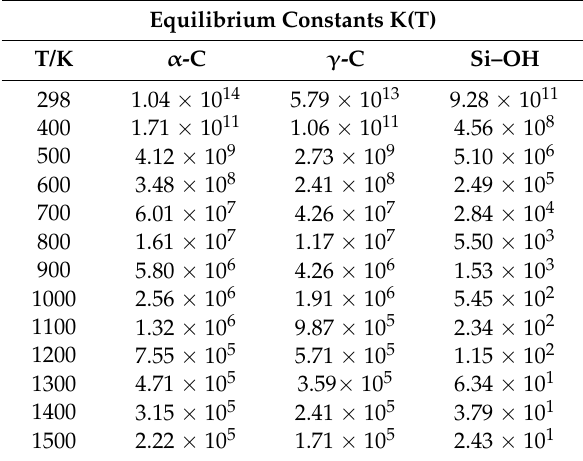
Table 2. Equilibrium Constants K (T) calculated at the B3LYP/6-311G (d, p)